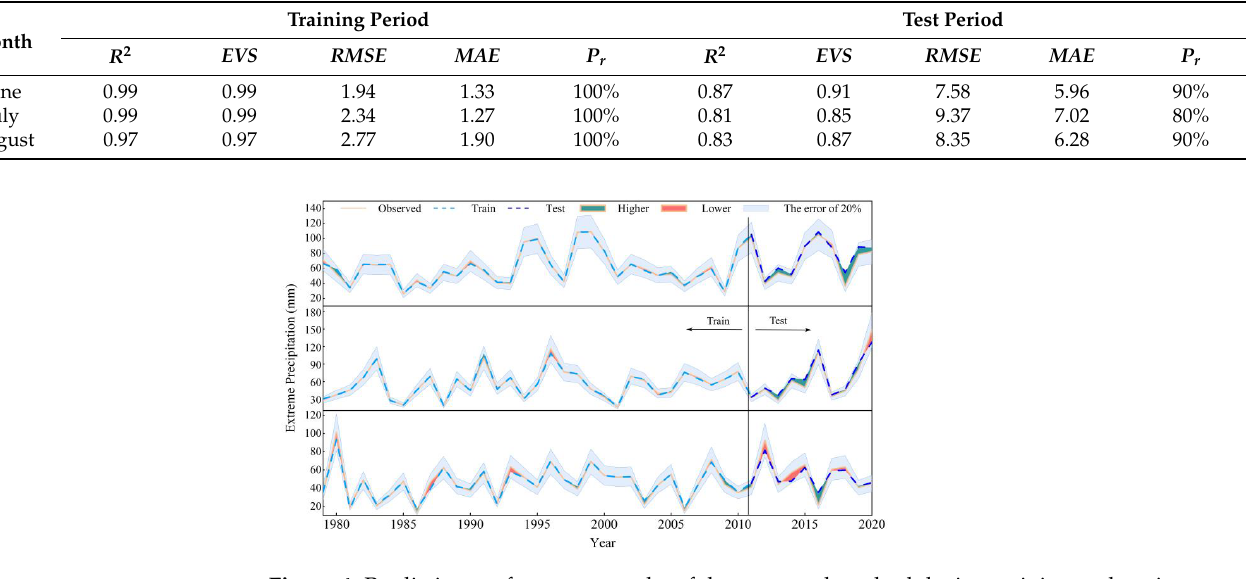
Figure 5. FI of RF in June, July, and August.